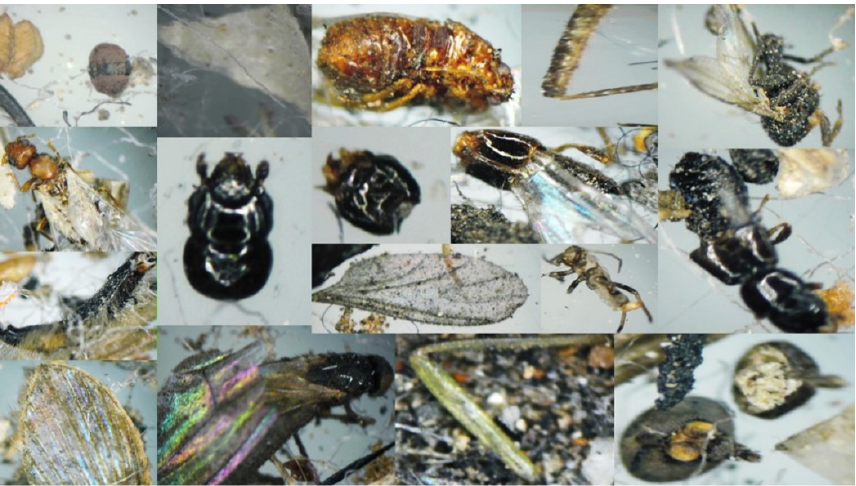
Figure 3. Mosaic of animal debris collected by the CAFs.